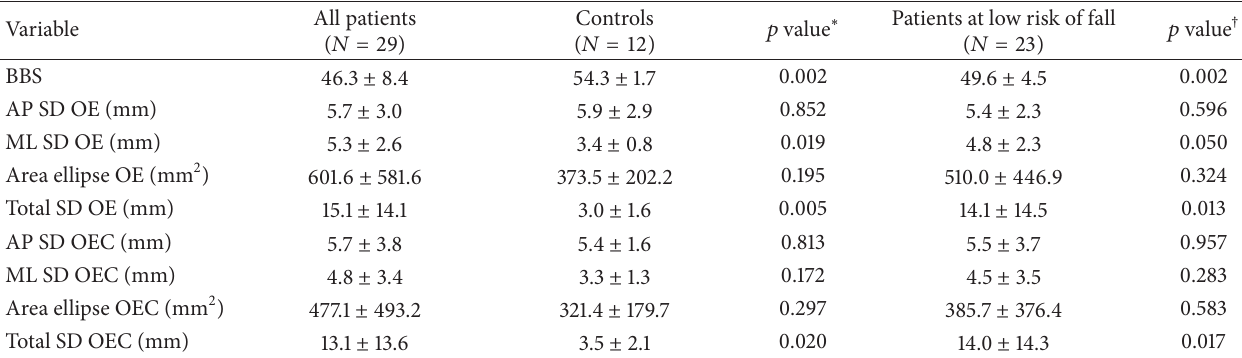
Table 2: Values of BBS and posturographic parameters observed in patients and